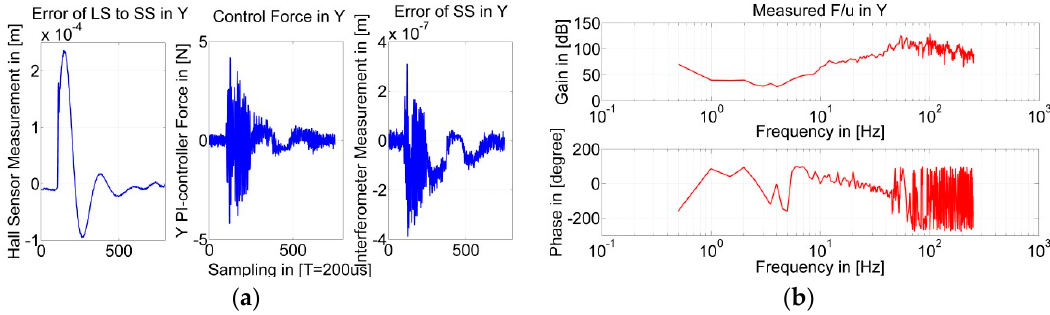
Figure 10. ( a ) Recorded relative position, SS controller force, and SS actuator stage positioning error; and ( b ) Bode diagram of the transfer function of controller force to relative position.